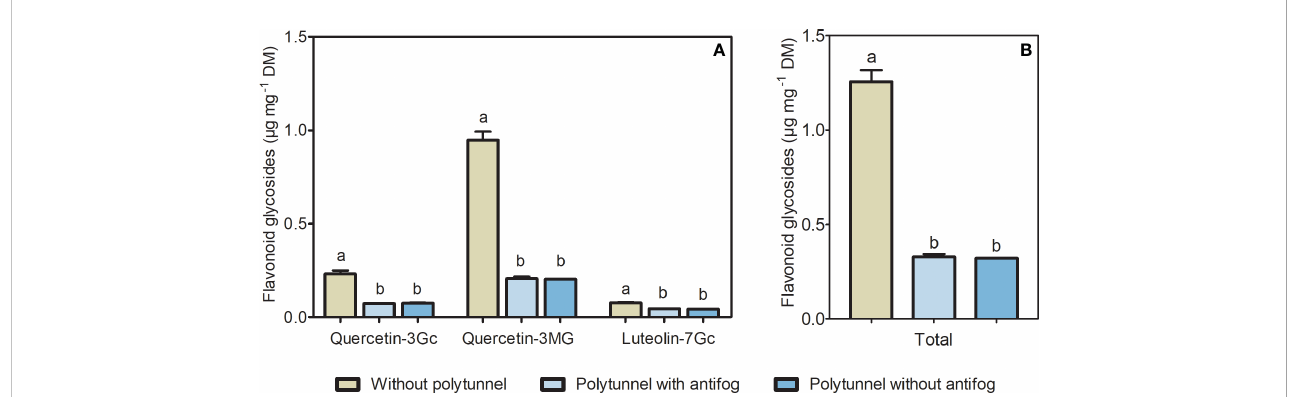
FIGURE 3 Flavonoids in lettuce cultivated without or under polytunnels. (A) Individual, and (B) total content of fl avonoid glycosides ( m g mg -1 DM) in lettuce grown without or under polytunnels with and without antifogging additives. The fi rst experimental repetition in April is shown. The data are expressed as mean ± SE (n = 4). Signi fi cant differences (p ≤ 0.05) between treatment of individual compounds and total content are indicated by different letters. Gc, glucuronide; MG, malonyl